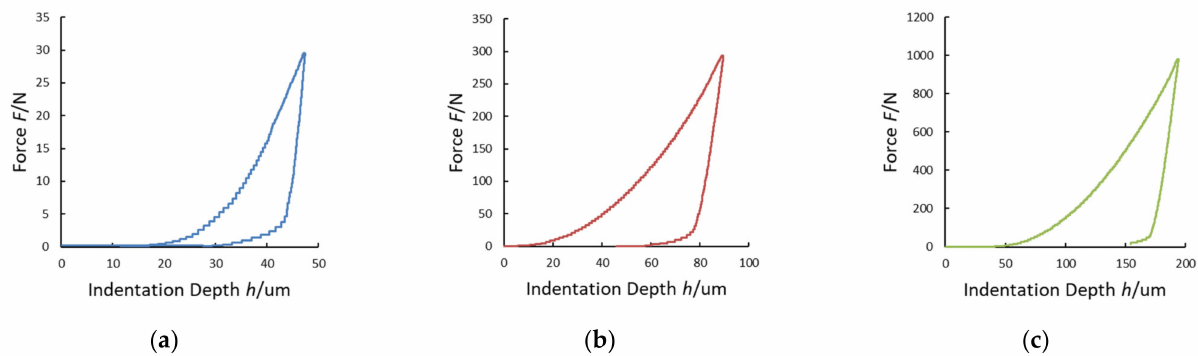
Figure 8. Loading–unloading curves of the HV tests on aluminum alloy: ( a ) HV3; ( b ) HV30; ( c )